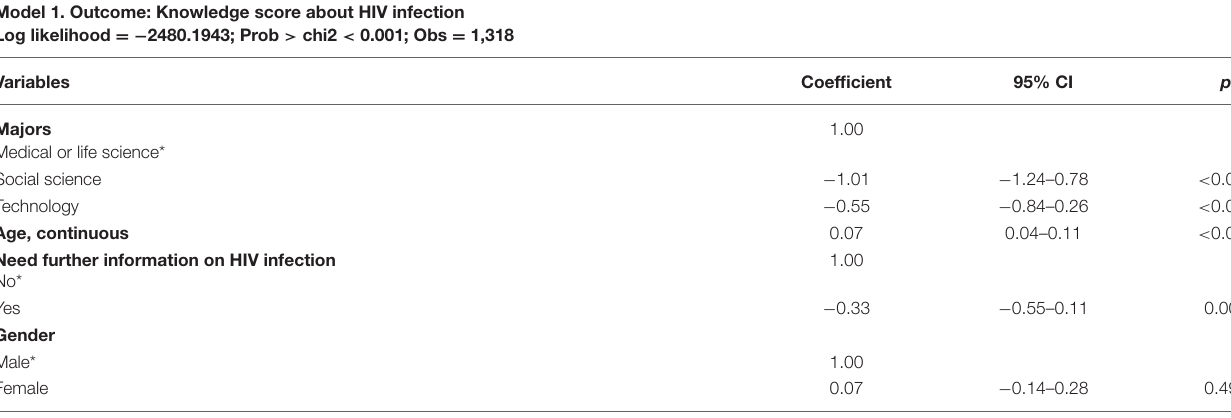
TABLE 2 | Results of the regression models for potential determinants of the outcomes of